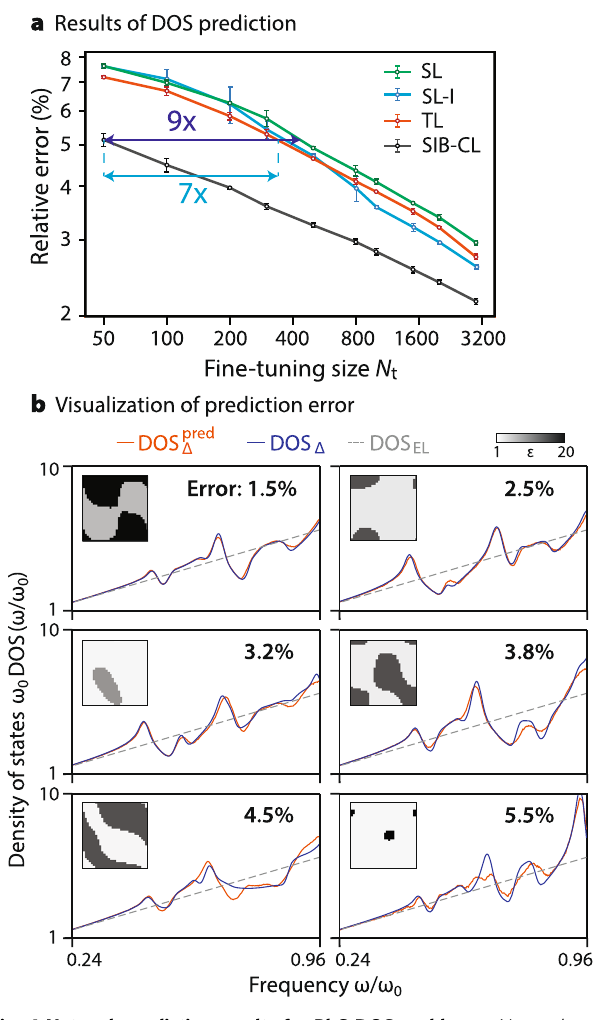
Fig. 4 Network prediction results for PhC-DOS problem. a Network prediction error against fi ne-tuning dataset sizes, N t , between 50 and 3000, when using our SIB-CL framework (based on SimCLR 53 for contrastive learning) compared against the baselines: direct supervised learning (SL) and standard approaches involving transfer learning (TL) or involving invariances via data augmentation (SL-I). A 9-fold (7-fold) reduction in target data requirements is obtained by using SIB-CL over SL (SL-I, TL) at a relative error target of ~5.1%. Error bars show the 1 σ uncertainty level estimated from varying the data selection of D t . b Examples of the DOS spectrum predicted by the SIB-CL-trained network compared against the actual DOS at various error levels (insets depict associated unit cells, shown here using the network-inputs' resolution of 32 × 32).